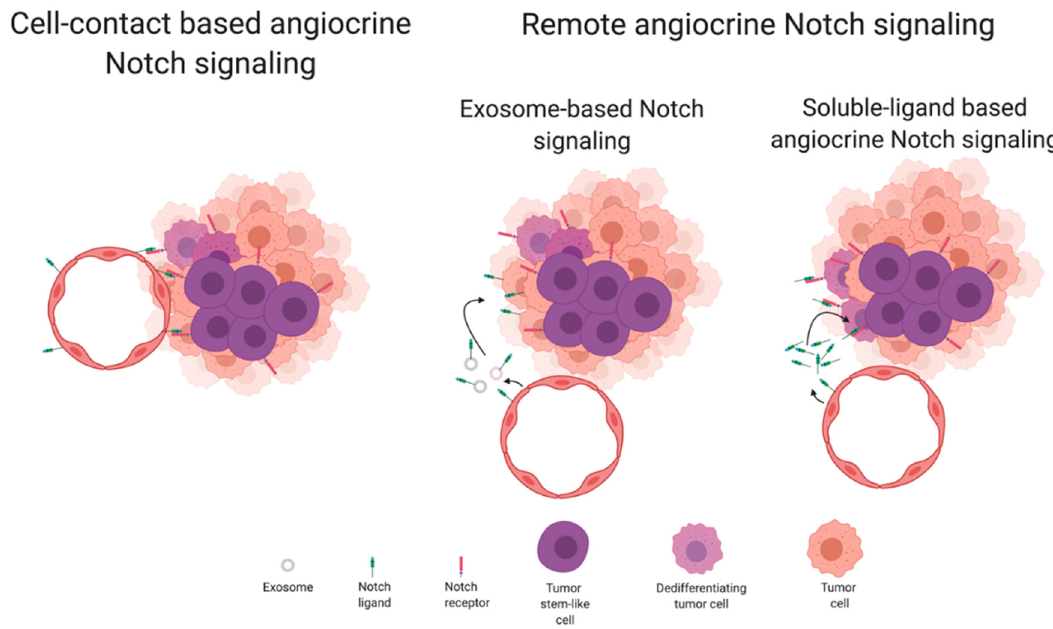
Figure 3. Modes of Notch-based angiocrine signaling in the tumor microenvironment. Cell-contact- based angiocrine Notch signaling occurs between ligand-bearing endothelial cells and Notch- receptor-bearing neighbouring tumor cells. Commonly, the end-result seems to be the induction of survival, stemness and invasion. Remote angiocrine Notch signaling occurs when endothelial cells release Notch-ligand-bearing exosomes or soluble forms of the extracellular region of Notch ligands. In the first case, the exosomal ligands can either activate Notch receptors in tumor cells or be incorporated in tumor cells before being functional. Doing so, they influence the tumor cell dedifferentiation process and tumor stem-like cells’ self-renewal.